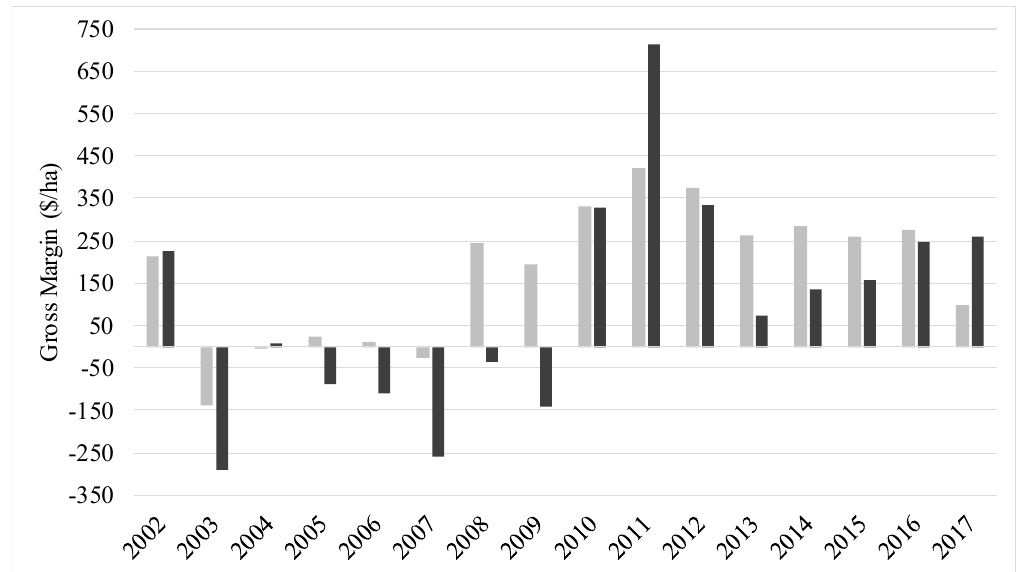
Figure 3. Annual gross margins (GM) for sheep enterprise with constant (grey bars) and variable prices (dark bars). Total gross margins (TGM) were negative 35% of the time (Figure 4a) for all D:E scenarios. As a tool for sensitivity analysis, the tornado graph (Figure 4b) showed that